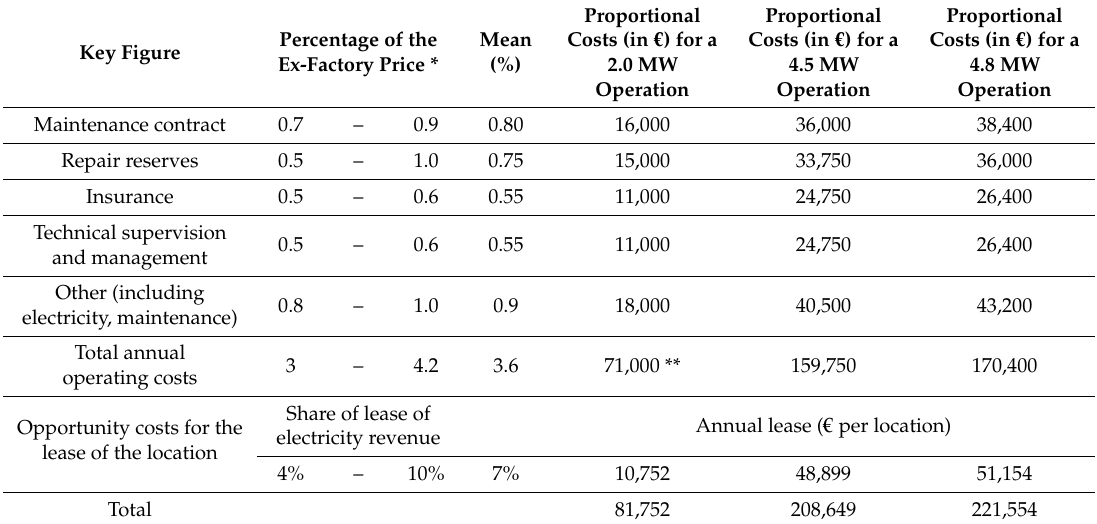
Table 3. Annual operating costs of the old wind turbine and the alternative new wind